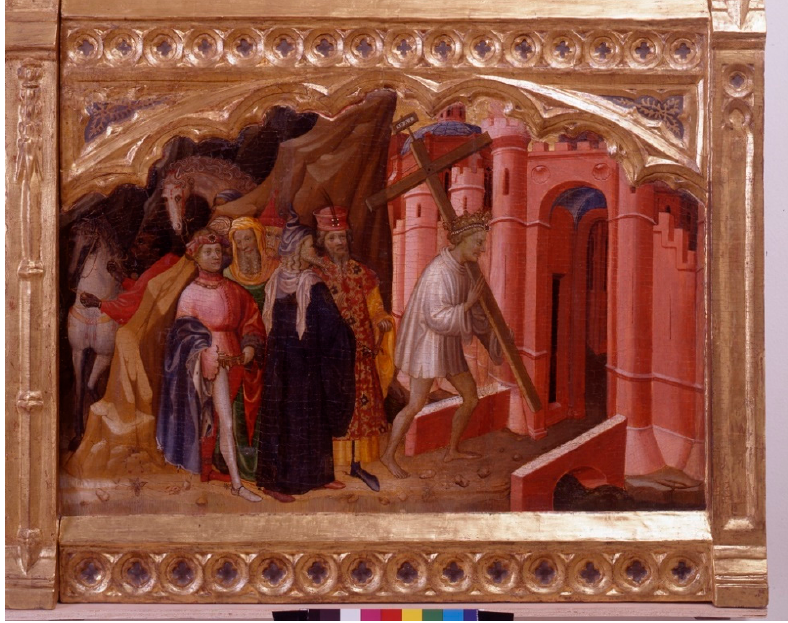
Figure 2. Altarpiece of the Holy Cross: Heraclius returns the Holy Cross to Jerusalem. Valencia, Museo de Bellas Artes, n. inv. 254. Used by permission.